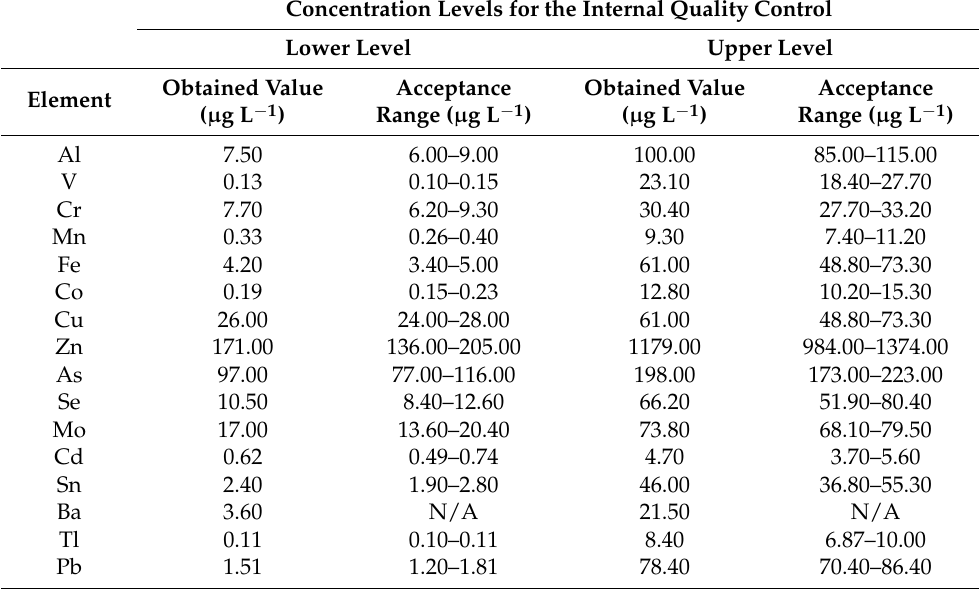
Table 4. Internal quality control